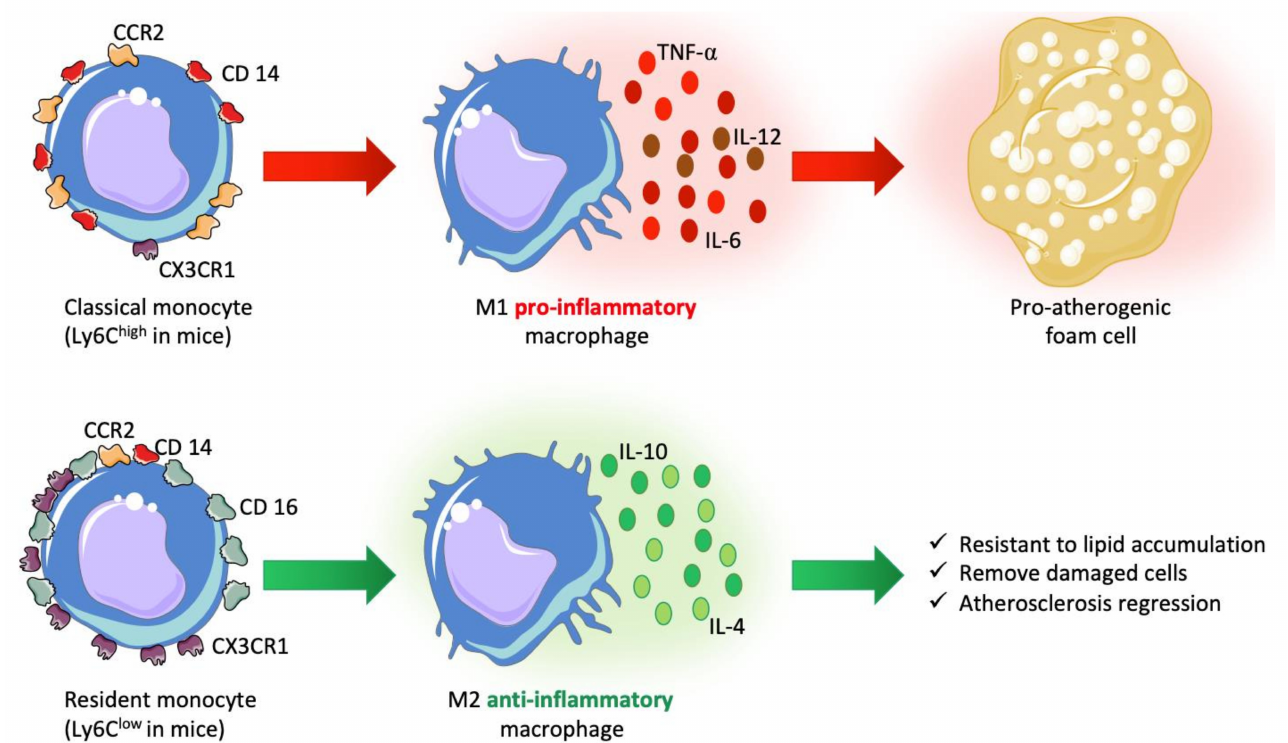
Figure 1. Monocyte subsets and their glycoproteins. Depending on the type of glycoprotein expressed at their membrane, monocytes can be classified in different subsets. Classical monocytes expressing CCR2 and CD14 are associated with pro- inflammatory macrophages. They actively participate in the aggravation of atherosclerosis by secreting pro-inflammatory cytokines and may become foam cells. On the other hand, resident monocytes expressing CX3CR1 and CD16, are associated with anti-inflammatory macrophages, are resistant to lipid accumulation and promote the resolution of atherosclerosis, notably by carrying out an effective